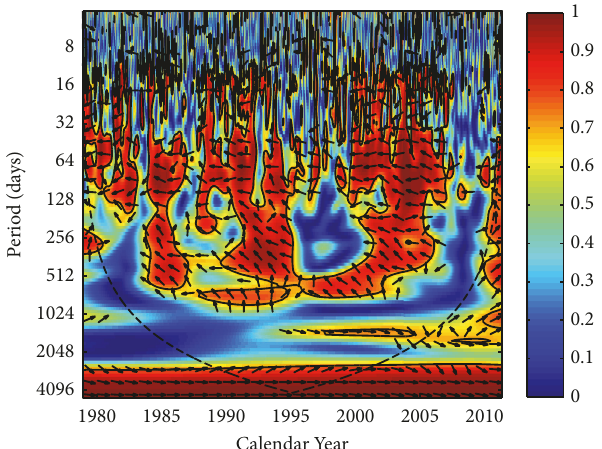
Figure 2: Wavelet coherence of the daily TSI and sunspot area. The dashed black line indicates the COI where edge effects might distort the picture, and the 95% confidence level is shown as a thick contour, which is estimated by Monte Carlo method. The relative phase relation is shown as arrows (with in-phase pointing right, antiphase pointing left, and TSI leading sunspot area by 90 ∘ pointing straight down).